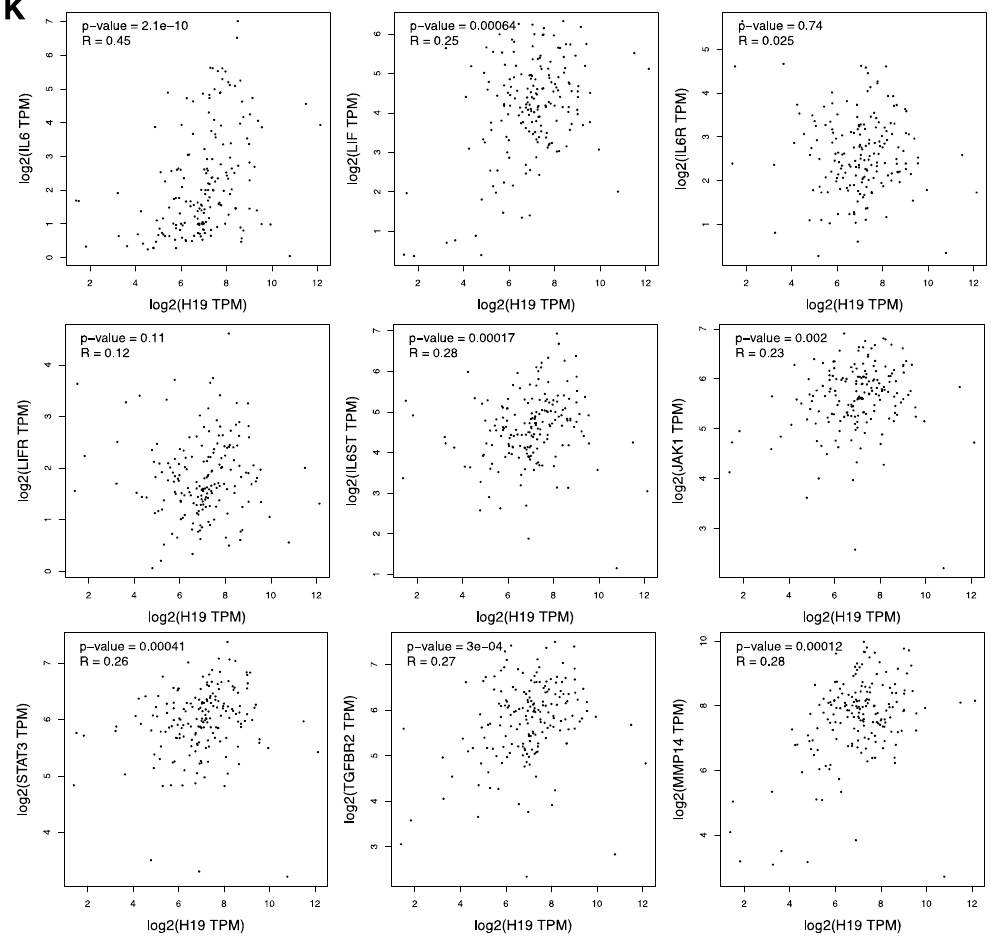
Figure 8. The correlation of gp130/STAT3 pathway-related factor expression with overall survival and H19 expression correlated with gp130/STAT3 pathway-related factors in patients with PDAC. Each survival curve was presented according to the online database GEPIA. ( A ) IL-6 , ( B ) LIF , ( C ) IL-6R , ( D ) LIFR , ( E ) gp130 (IL-6ST) , ( F ) JAK1 , ( G ) STAT3 , ( H ) TGF β -RII (TGFBR2) , ( I ) MT1-MMP (MMP14) , and ( J ) H19 . ( K ) The correlation of H19 and gp130/STAT3 pathway-related factor expression in patients with PDAC was assessed using Spearman rank correlation analysis according to the online database